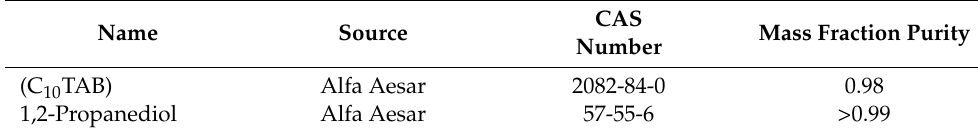
Table 7. Characteristics of the